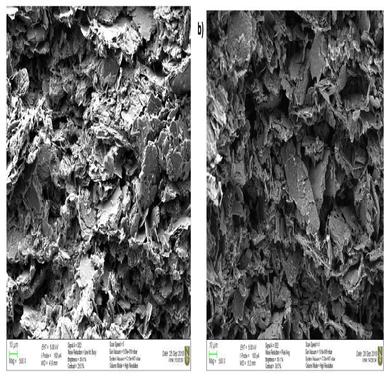
grayscale image of SEM micrographs a) Sample 1; b) Sample 2; c) Sample 3.